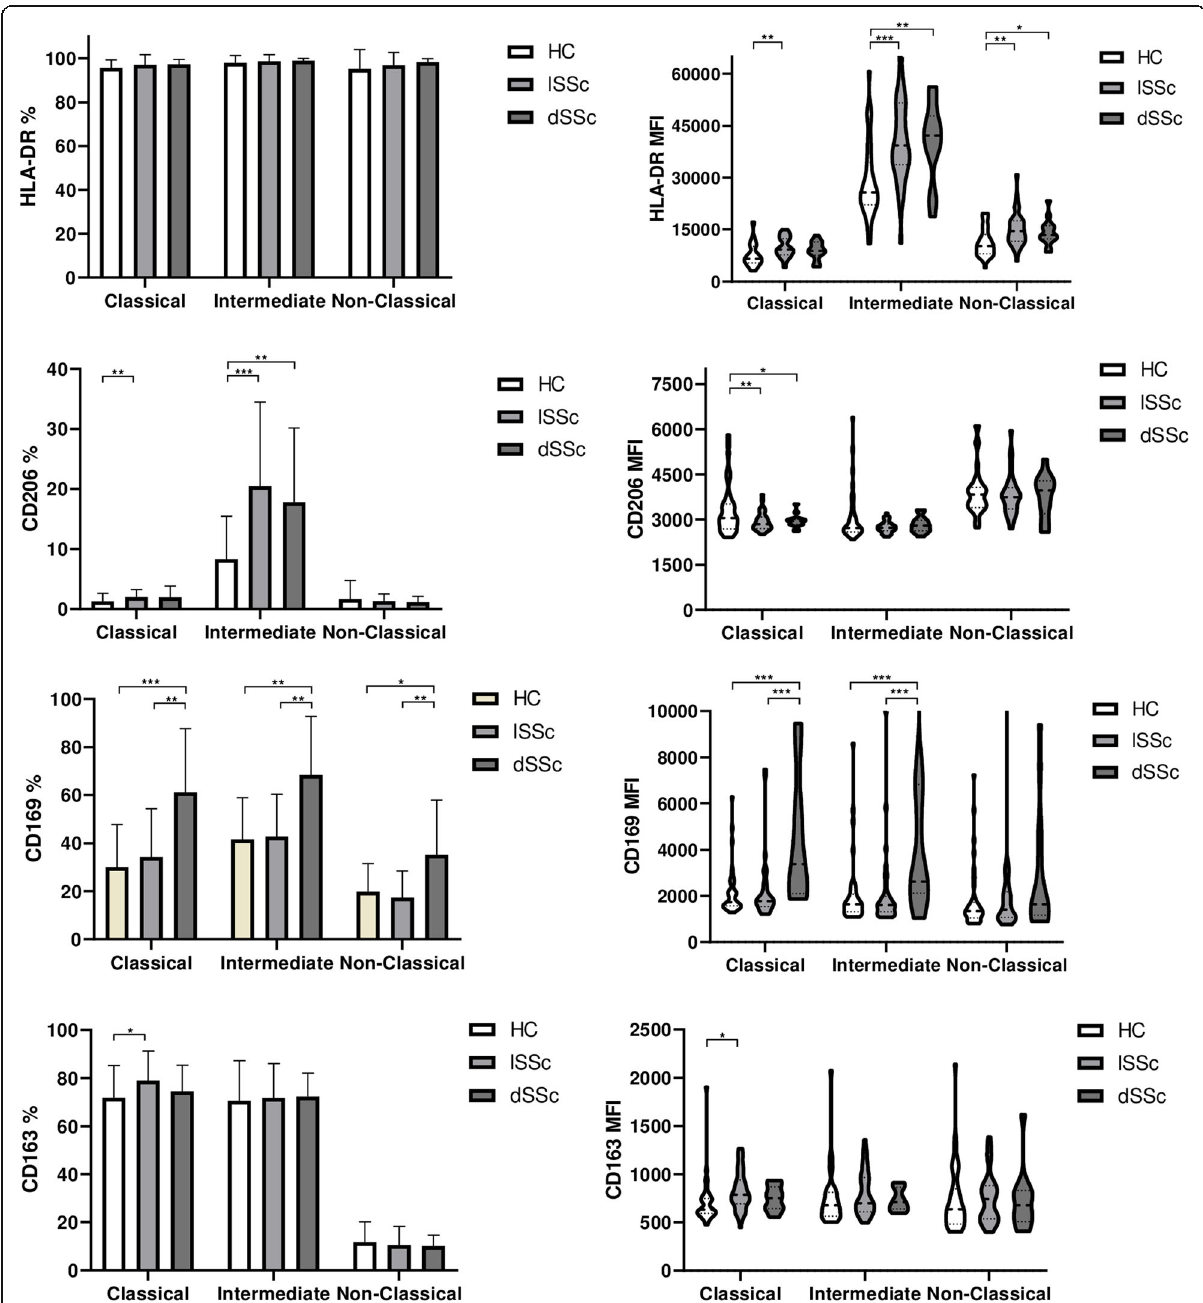
Fig. 4 Expression of surface receptors under study on monocyte subpopulations of systemic sclerosis patients divided by disease subtype in lSSc ( n = 36) and dSSc ( n = 14) compared with healthy controls (HC) ( n = 38). ANOVA with Tukey correction for symmetric distribution and Kruskal- Wallis with Dunn correction for asymmetric distribution. MFI: mean fluorescence intensity. SSc: systemic sclerosis; HC: healthy controls; lSSc: limited systemic sclerosis; dSSc: diffuse systemic sclerosis. * p < 0.05; ** p < 0.01; *** p <